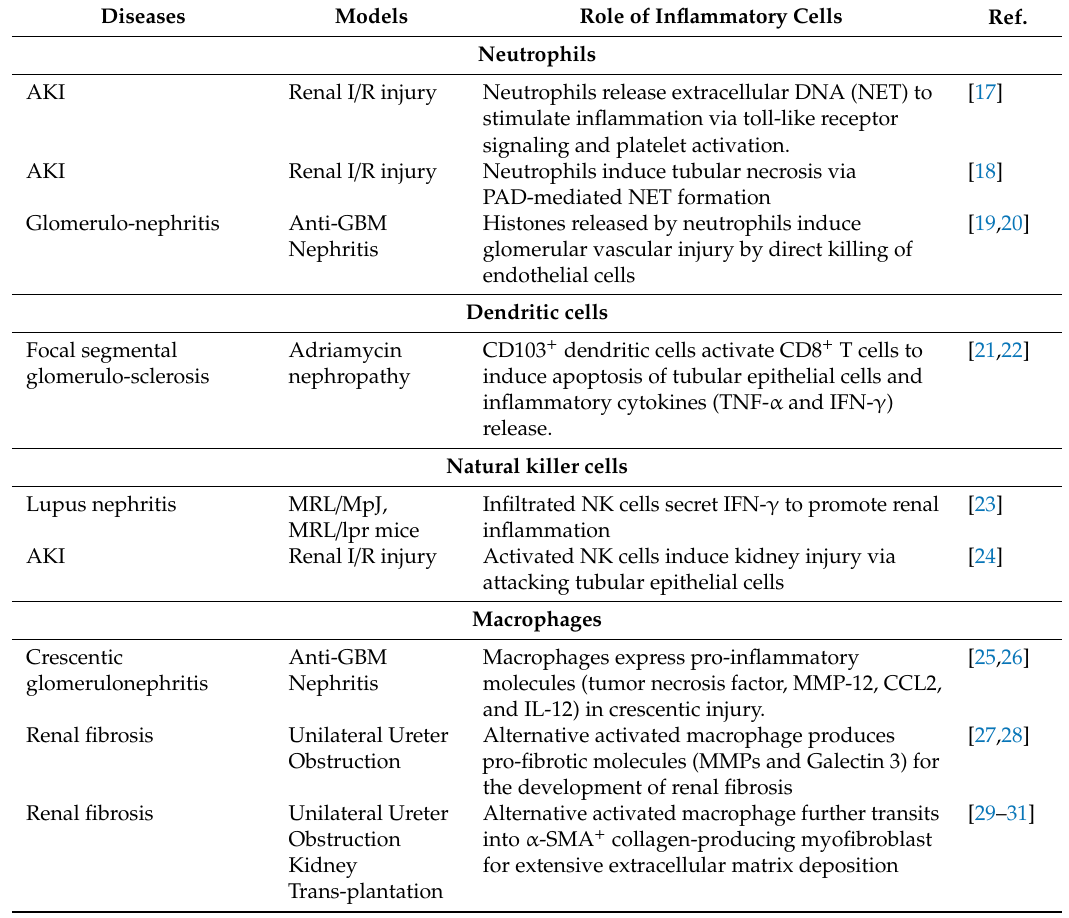
Table 1. Summary of the role of innate immune cells in the pathogenesis of kidney